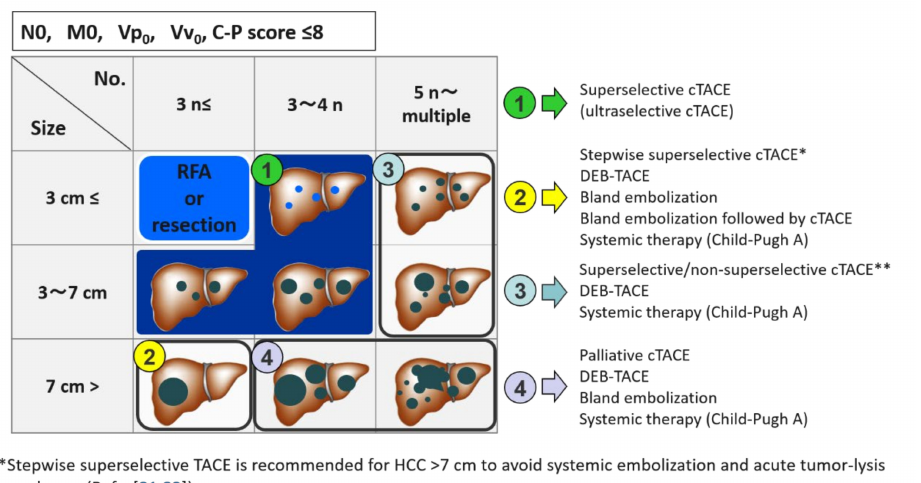
Figure 5. Our TACE strategy according to the patient and tumor conditions. Abbreviation: C-P, Child-Pugh; n , number; RFA, radiofrequency